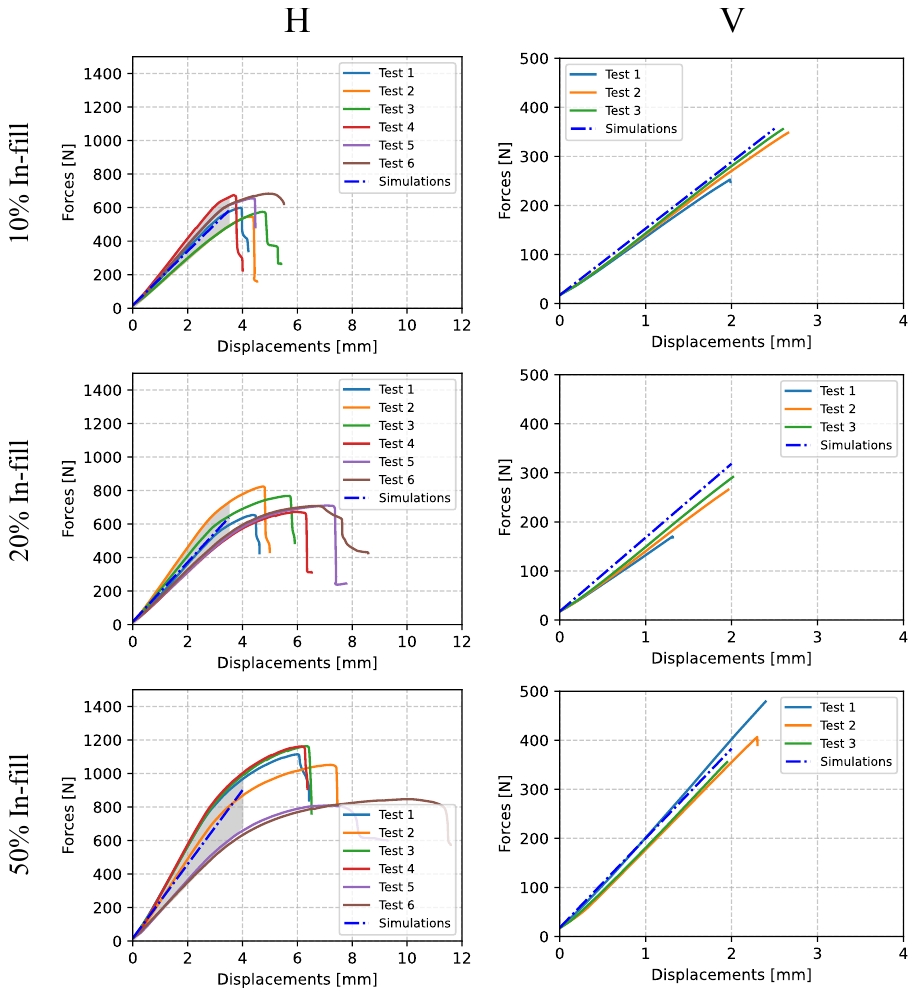
Figure 9. Bending test force–displacement curves for ABS/PC. The experimental stiffness ( K experimental ) was computed as the slope of the resulting force–displacement curve in the linear regime for each test, and the computational stiffness ( K simulation ) was obtained also as the force–displacement ratio shown by the simulation data. These simulations were performed with Comet [55], an in-house software. Table 5 shows the obtained values for these stiffnesses, as well as their relative